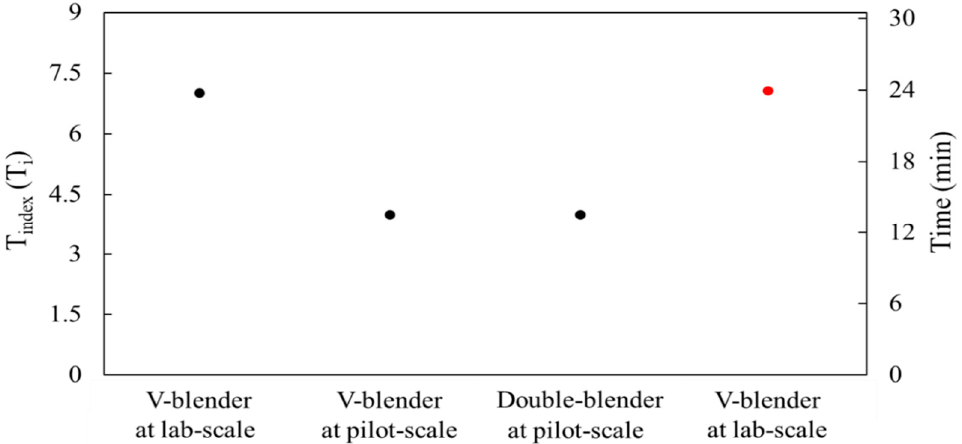
Figure 11. Comparison of T i values and blending time (min) that satisfied the target values for the drug content and CU. The black points corresponding to the left axial are the T i values for each blending simulation and the red point corresponding to the right axial is the blending time for the blending experiment at laboratory-scale.